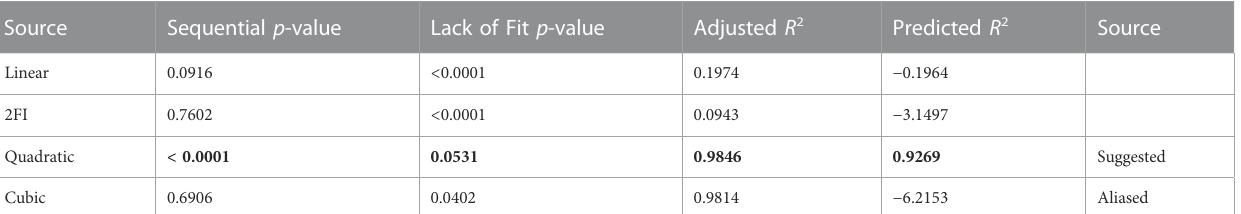
TABLE 7 Fit Summary of biolubricant yield.